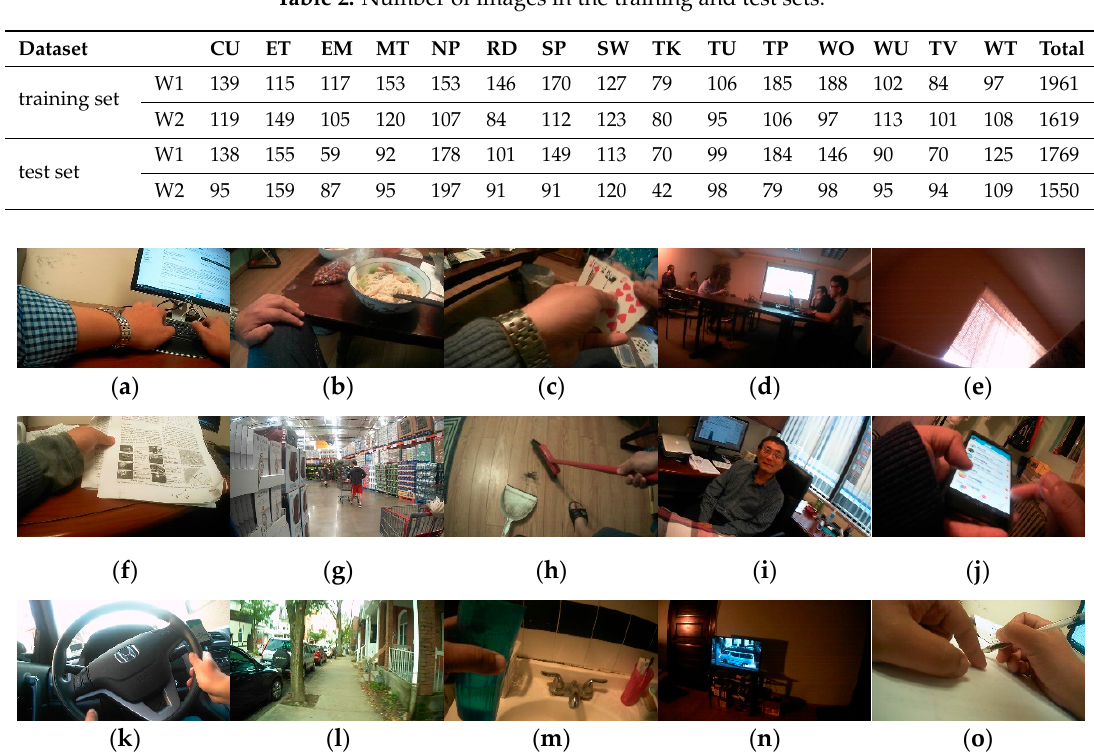
Figure 10. Example image of each activity in the training set. Images ( a – o ) correspond to CU, ET, EM, MT, NP, RD, SP, SW, TK, TU, TP (driving), WO, WU, TV, and WT, respectively.